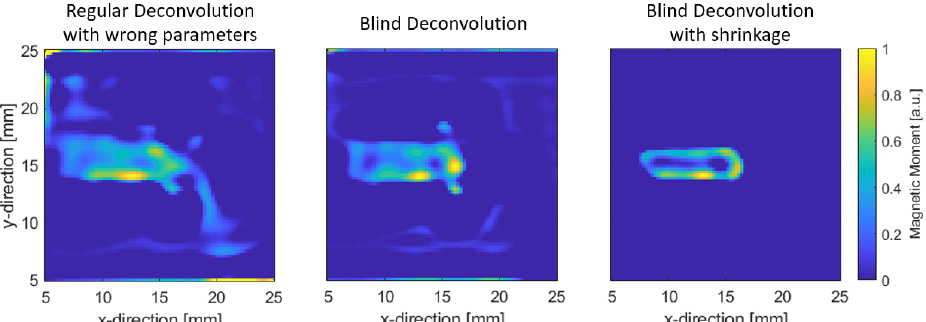
Figure 10. ( Left ): regular deconvolution with sensitive axis off by 20 ◦ ; ( middle ): Blind Decon- volution as outlined in Algorithm 2; ( right ): Blind Deconvolution with additional shrinkage by soft